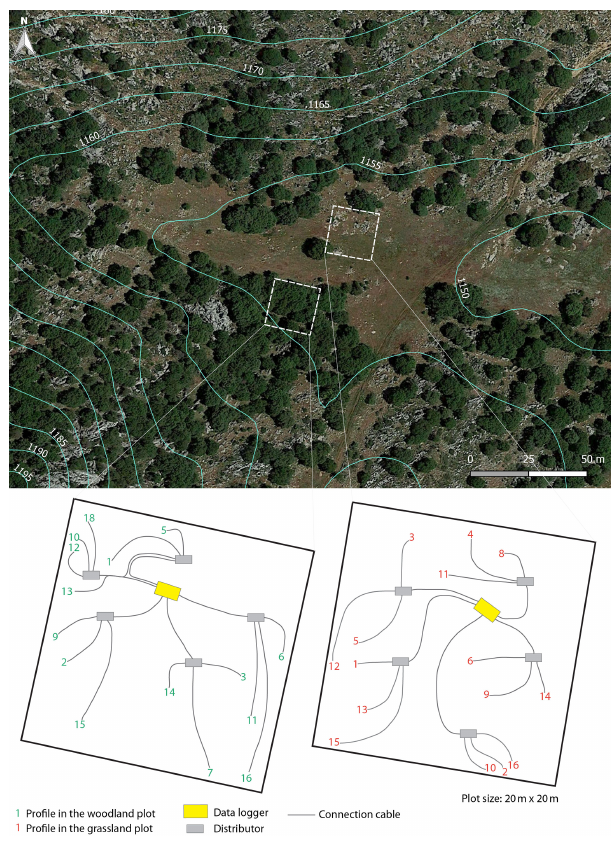
Figure 2. Plot locations, profile distributions, and cable connec- tion maps at the Spanish site. The yellow boxes represent the data loggers. The grey boxes represent the distributors from Truebner GmbH that allow for the connection of 11 probes to one connec- tion of the logger (one logger has four connections). Map data: © 2015